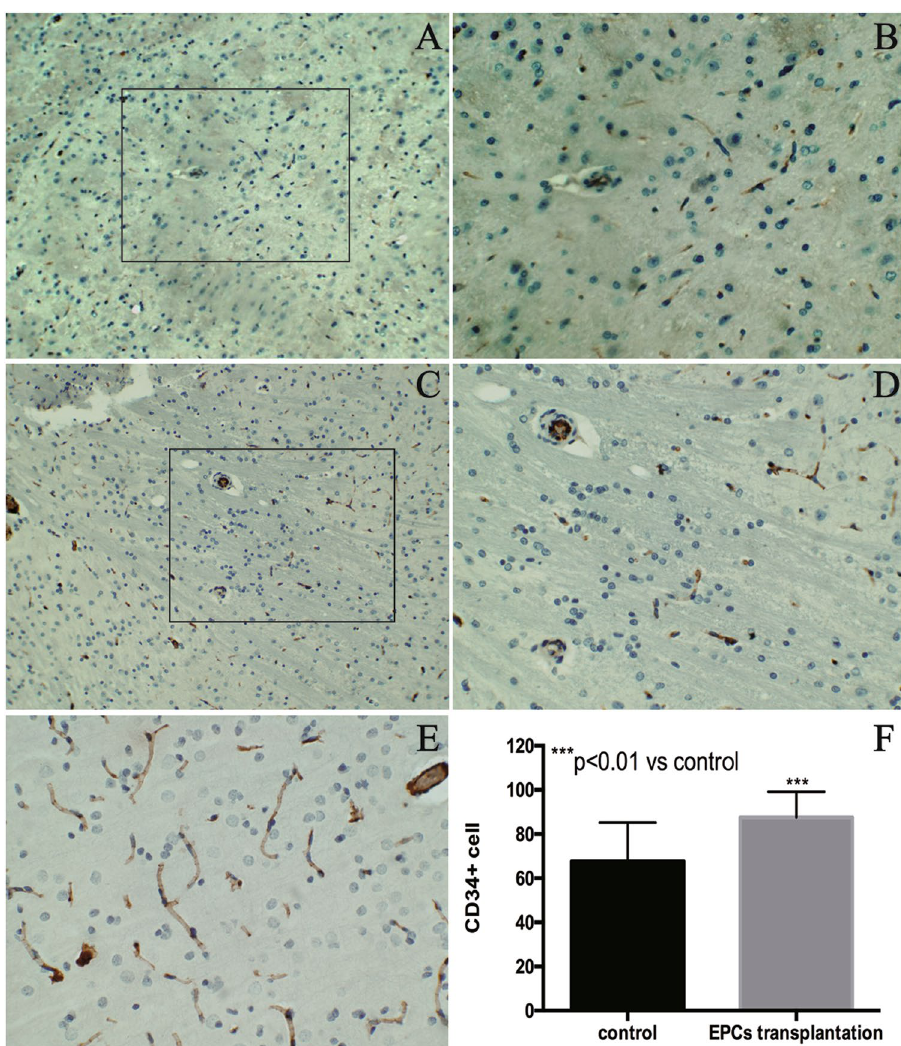
Figure 8. Effect of EPCs on angiogenesis. CD34 was used as a marker of microvascular endothelial cells to evaluate the effect of EPCs on angiogenesis. CD34 + cells expression in the EPCs transplanted group ( A , B ) and the control group ( C , D ). CD34 + endothelial–like vessel-lumen structure appeared in the brain tissue ( E ). The number of CD34 + cells in the traumatic zone increased after EPC transplantation as compared to the control group (P < 0.05 versus the control group, 100 × ). Data are presented as means ± SD ( F